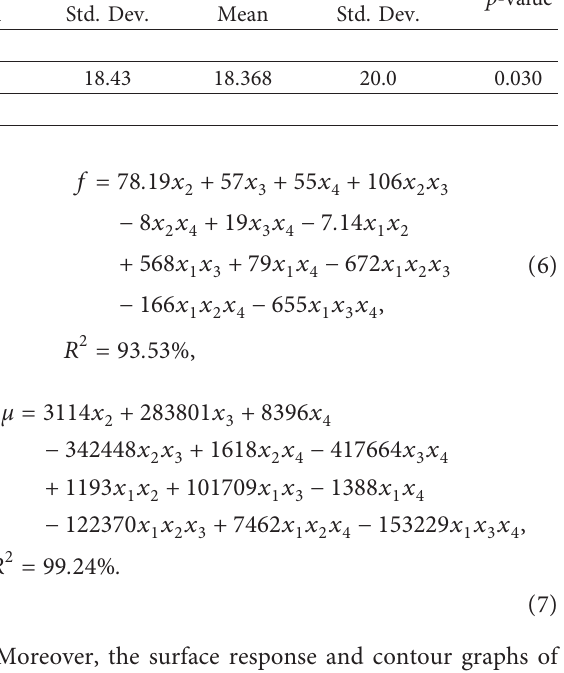
Table 6: Paired t -test for the MSE of RSD predictions of strength and permeability.